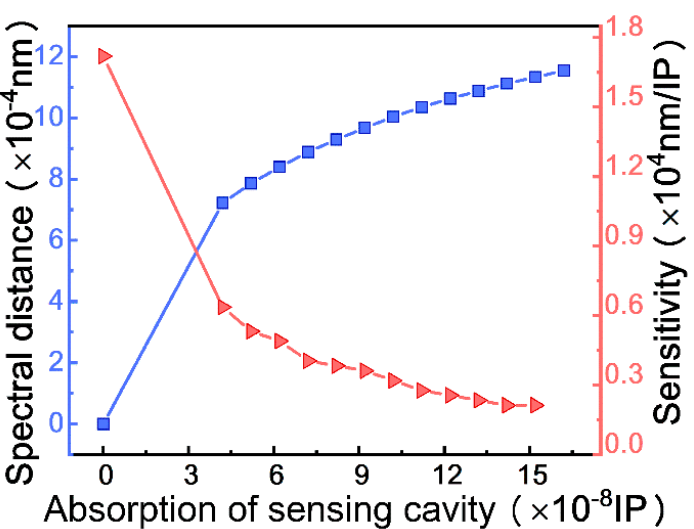
Figure 7. Graph of spectral distance (blue line) and sensitivity (red line) as a function of the imagi- nary part of RI of the cavity S representing the absorption.